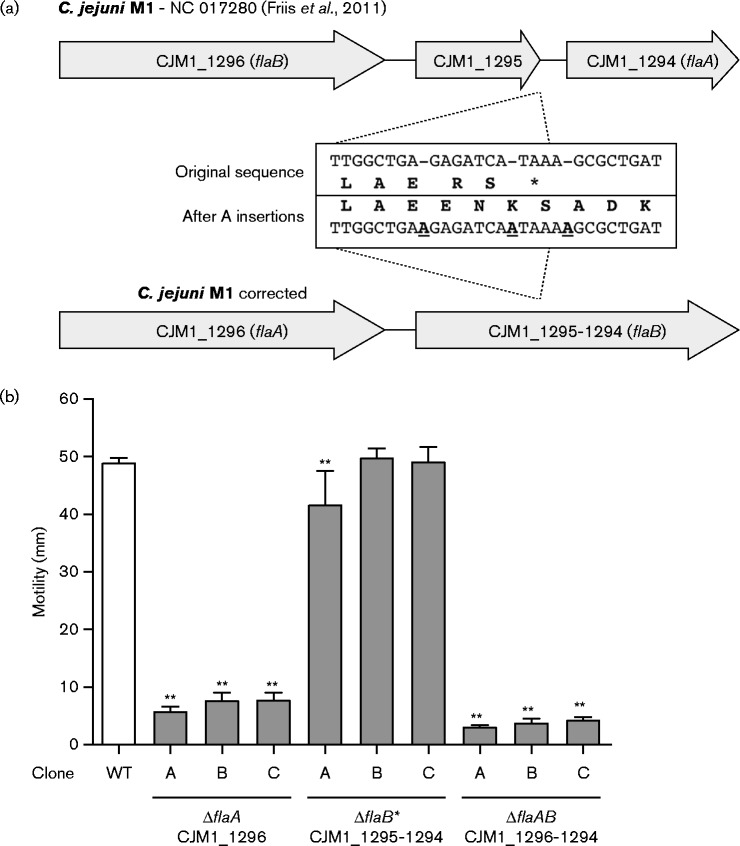
Sequence corrections in the C. jejuni M1 flagellin locus and motility analysis of flagellin locus gene deletion mutants. (a) Insertion of three A nucleotides at the 3′ of CJM1_1295 led to elimination of the TAA stop codon and resulted in CJM1_1295 and CJM1_1294 being merged into one large ORF. (b) Motility was assessed on 0.4 % (w/v) agar BHI plates after overnight incubation. Deletion of the full flaB CDS (flaB* mutant; CJM1_1295–1294) did not affect motility in clones B and C; however, we observed a very marginal decrease in motility in clone A. In contrast, mutant clones in which flaA (CJM1_1296) or both the flaA and flaB gene (flaAB; CJM1_1296 and CJM1_1295–1294) were deleted all showed severely attenuated motility. Differential motility of mutant clones was tested against the coupled WT strain with a Mann–Whitney test (n = 3). Data shown are the mean and sem, with **P < 0.01.